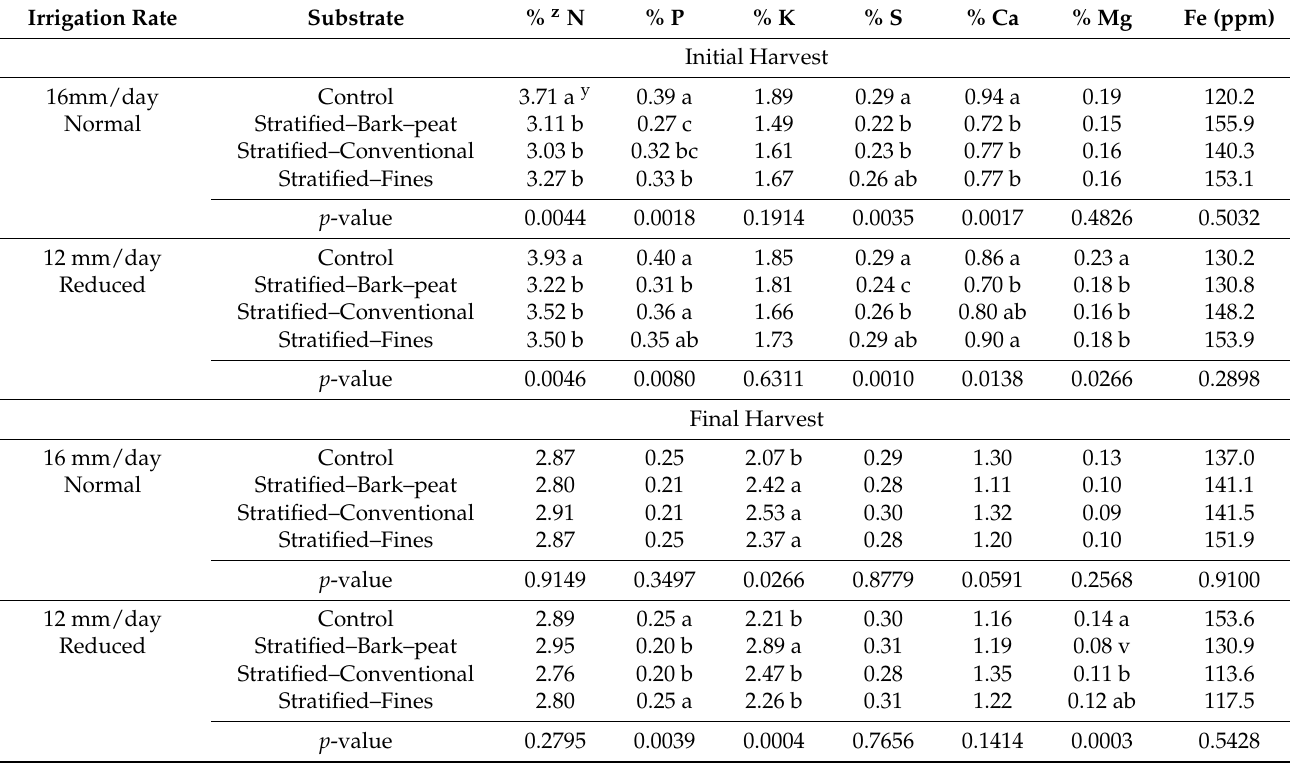
Table 3. Mineral nutrient concentrations in recently matured leaves of Red Drift roses at 125 days (initial harvest) and 341 days (final harvest) when being produced in a conventional pine bark substrate (control) or stratified substrates, in which either conventional pine bark substrate amended with 35% peat (by vol.; bark–peat), conventional pine bark (conventional), or fine pine bark (fines) was layered on top of a coarse screened pine bark. Plants were irrigated with 16 mm (normal; control) or 12 mm of water daily